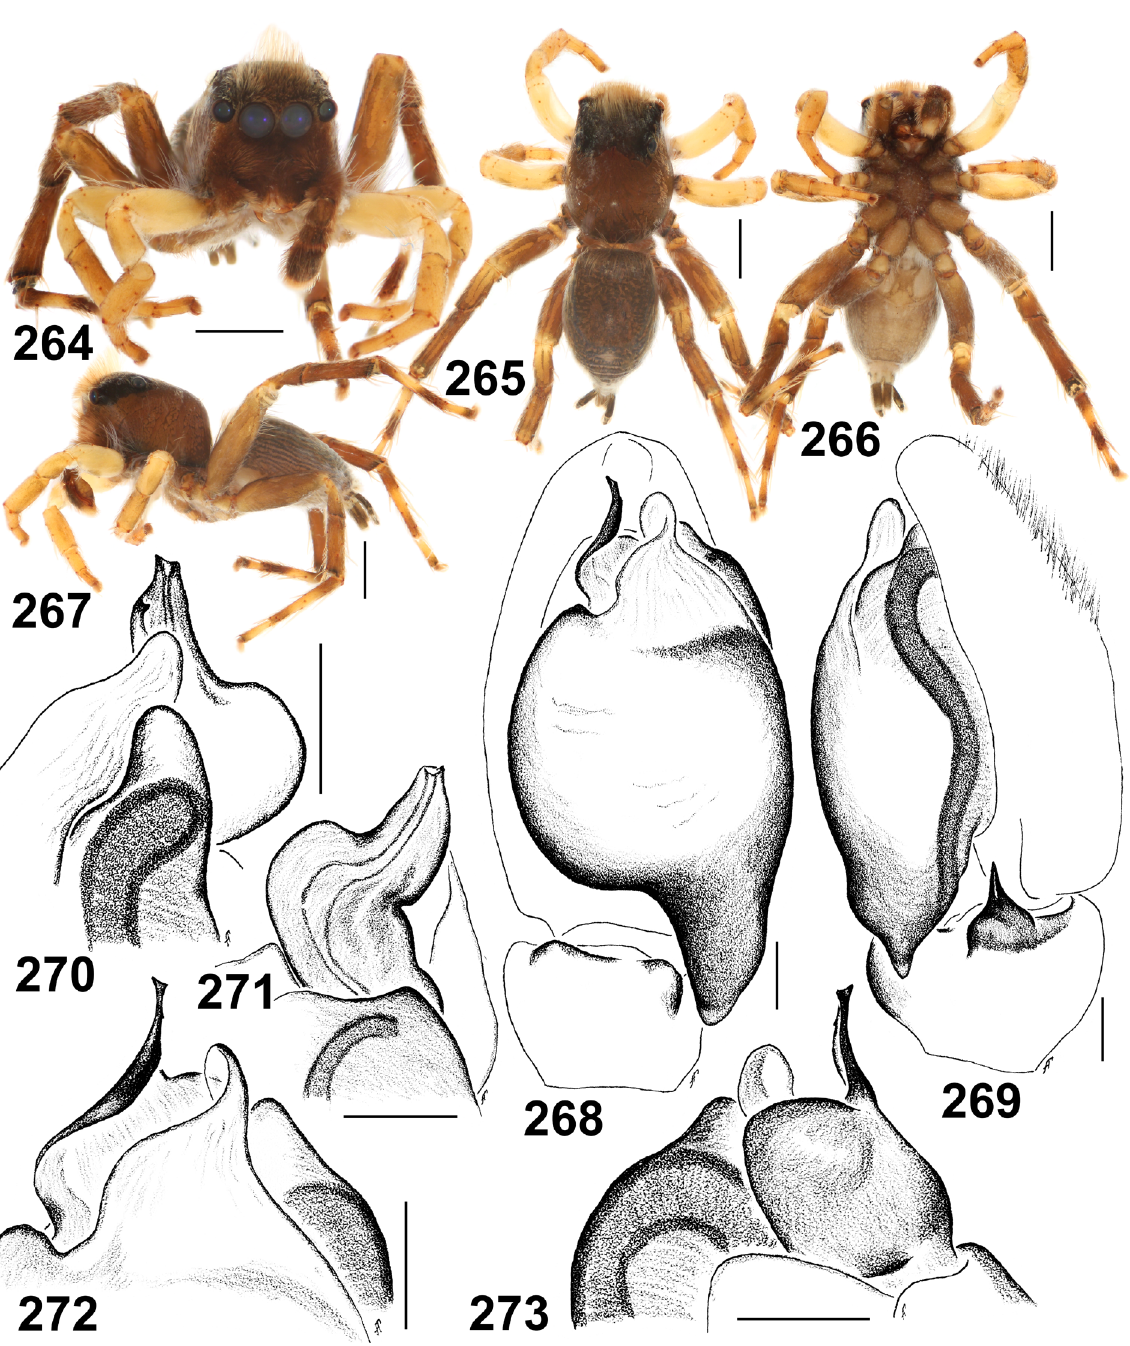
Figs 264–273. Stenaelurillus iubatus Wesołowska & Russell-Smith, 2011, ♂, from Nigeria (Ibadan) . 264–267 . General appearance. 268 . Male palp, ventral view. 269 . Male palp, retrolateral view. 270– 273 . Embolic division. 270 . Retrolateral view. 271 . Median view. 272 . Ventral view. 273 . Dorsal view. Scale bars: 264–267 = 1 mm; 268–273 =